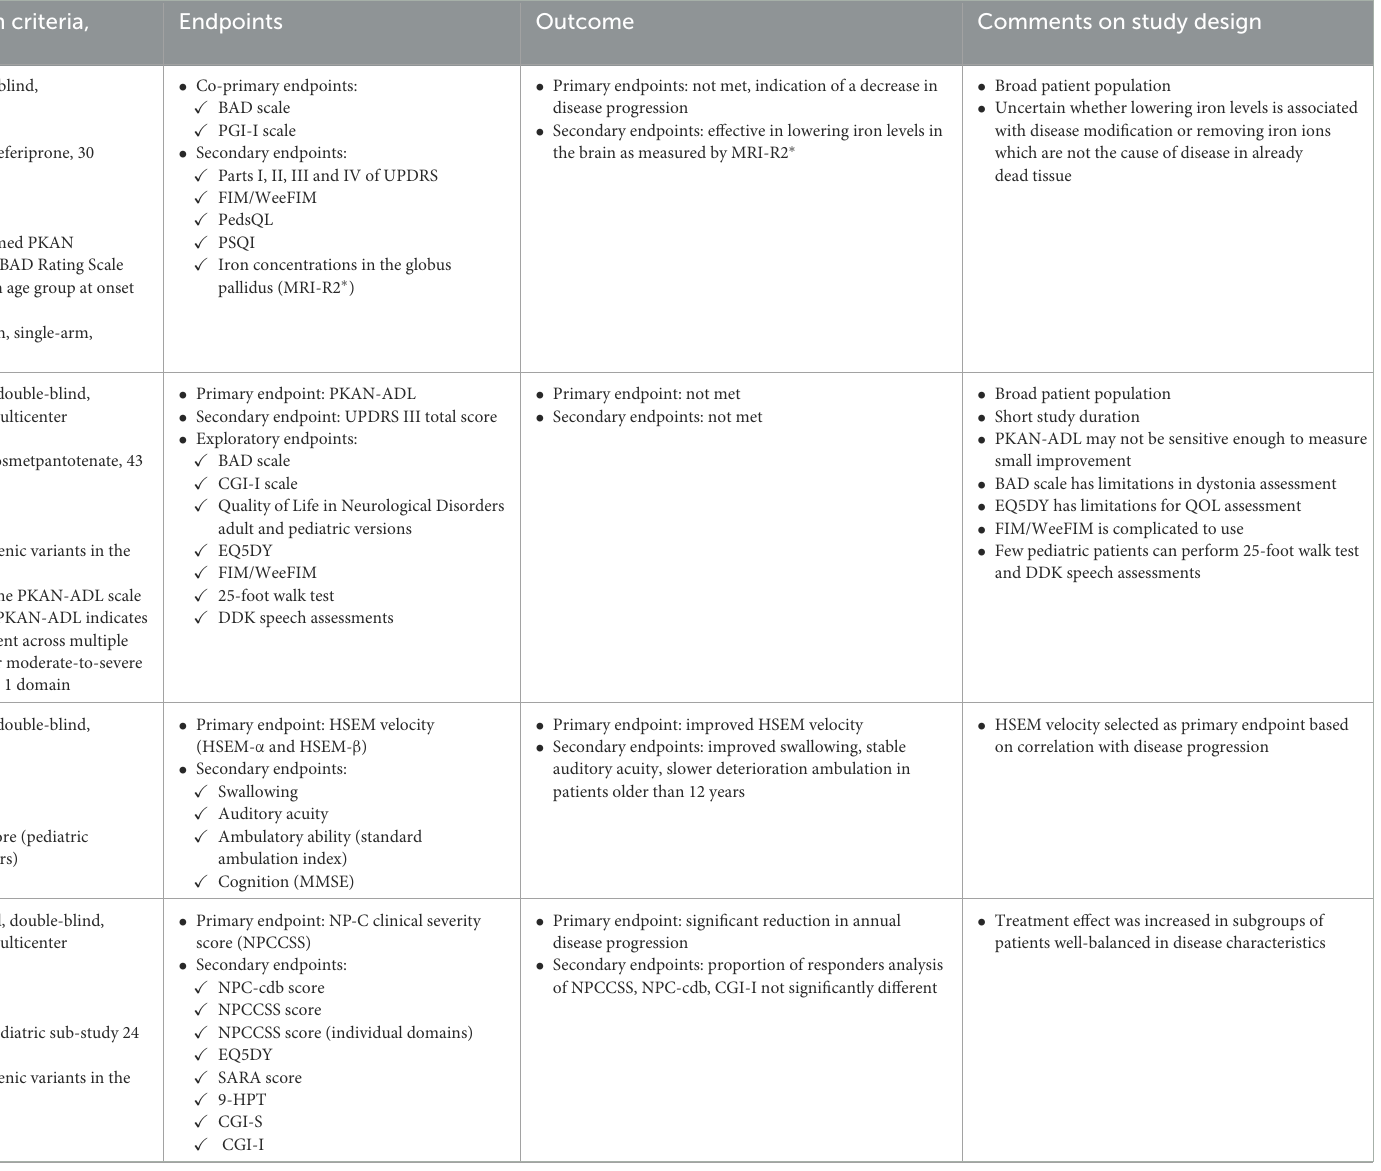
TABLE 3 Lessons learned from pivotal trials in PKAN and other neurodegenerative genetic disorders. Drug/company Design, inclusion criteria, Endpoints Outcome Comments on study design duration PKAN Deferiprone (iron chelator)